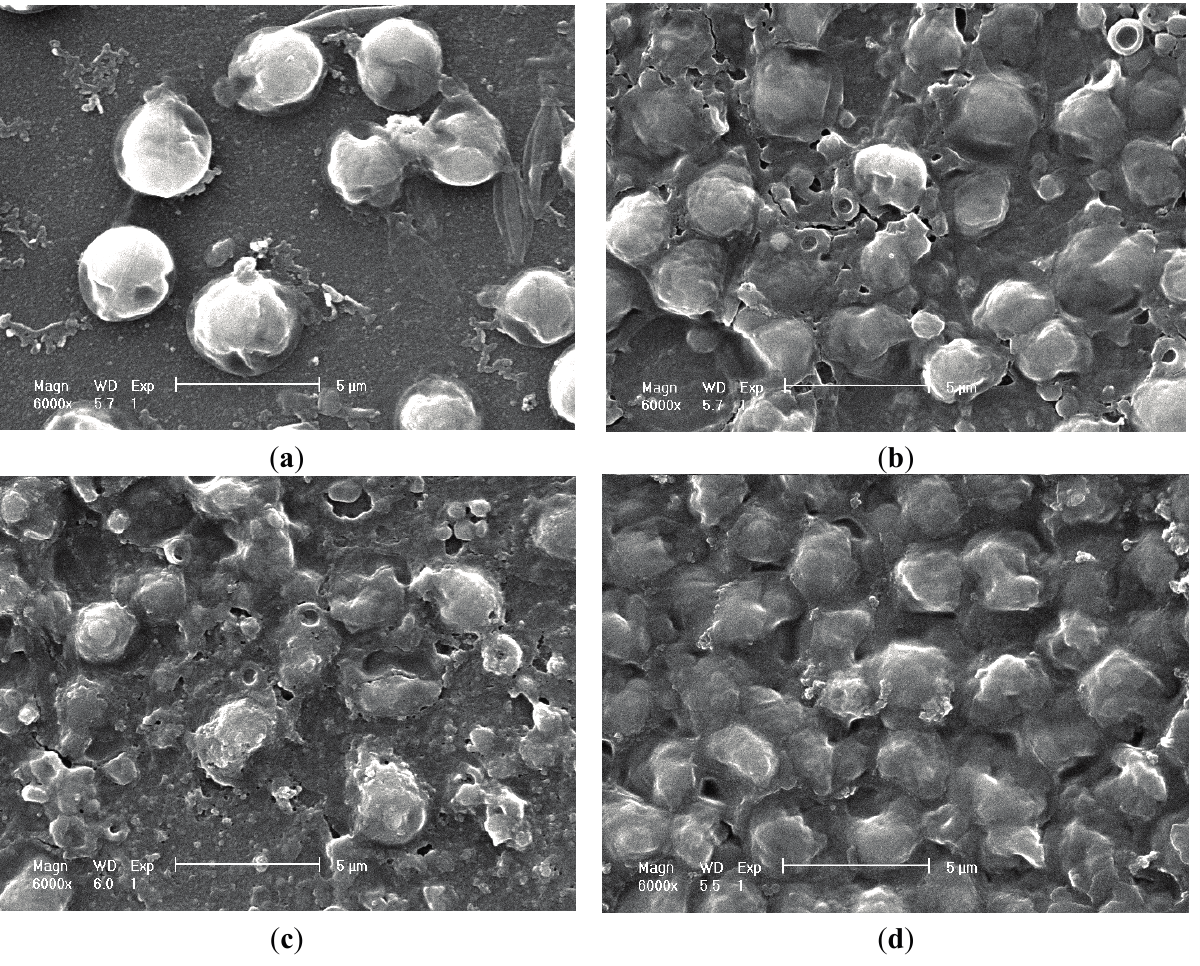
Figure 5. Scanning electron microscopy (SEM) images of algae cell before and after disruption (6000×). ( a ) SEM image of algae cells of Neochloris oleoabundans ; ( b ) SEM image of cells disruption with ultrasonic wave; ( c ) SEM image of cells disruption with high-pressure homogenization; and ( d ) SEM image of cells disruption with enzymatic